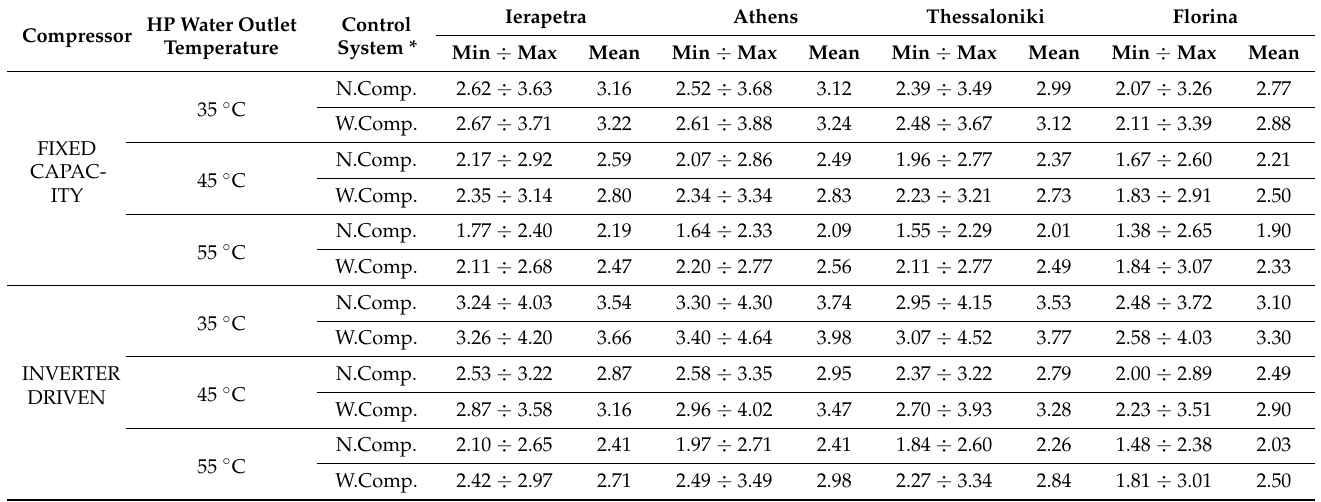
Table 3. Seasonal coefficient of performance range (SCOP) of fixed-capacity and inverter-driven